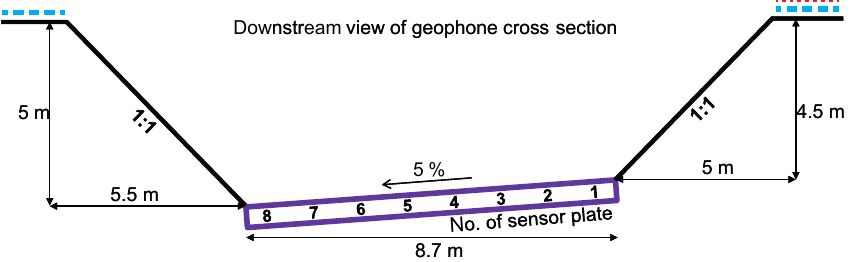
Figure 3. Schematic stream cross section at the geophone measuring site in both Fischbach and Ruetz. The steel–concrete pillar is located downstream of sensor plate 5. The sill with the steel plates is inclined towards the left bank to improve the resolution of the flow gauge measurements at low discharges. On the banks, the dotted horizontal line indicates the paved local road on the river’s right side at the Fischbach, and the two dashed horizontal lines indicate the gravelled parking lot on both river sides at the Ruetz.